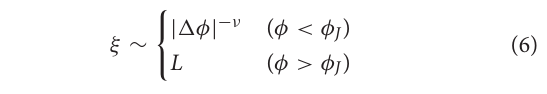
and φ increases as listed in the legend. The critical exponents are ν = 1.0 and λ = 4.0 as in Figure 3B , where slopes of the dotted and solid lines are given by − ν/λ and − 0.4, respectively. The shaded region exceeds the system size | 1φ | ν L / 2 for the case of φ = 0.90. (B) Scatter plots of the diffusivity over the shear rate D / ˙ γ and the length scale ξ , where φ increases as listed in the legend. The dotted line represents a linear relation D / ˙ γ ∼ ξ and the shaded region exceeds the system size L / 2 ≃ 44 d 0